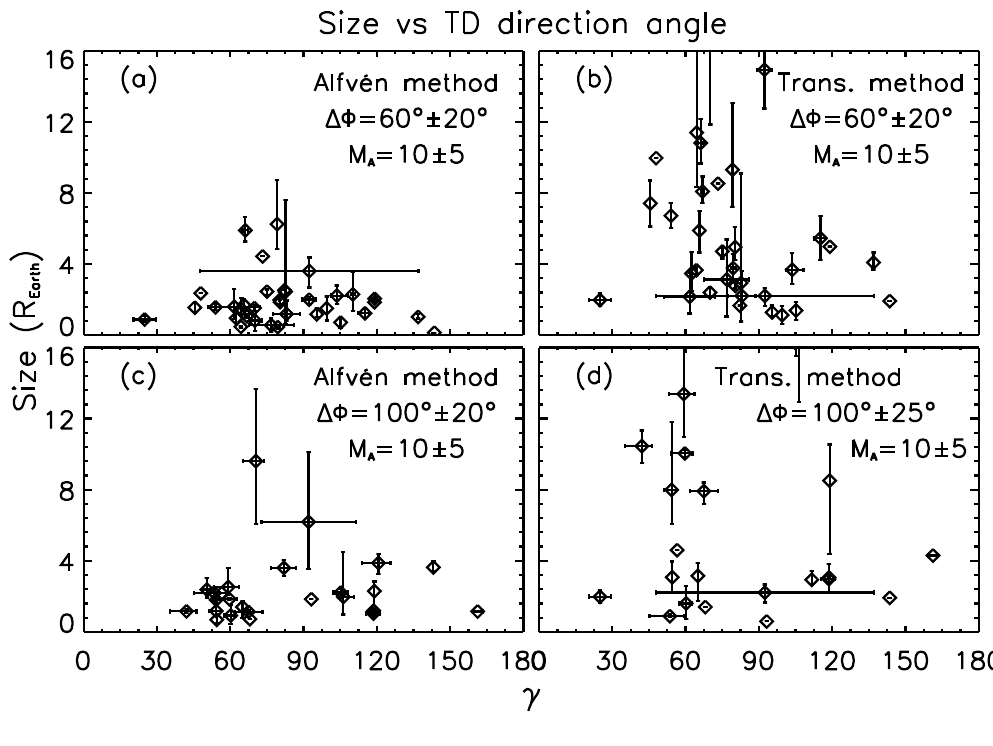
Fig. 6. The size- γ functions based on the size estimation by Alfv´en Mach velocity on the left and the transition speed on the right. The fixed solar wind speed was shown in Alfv´en Mach number. (a) 18 = 60 ◦ ± 20 ◦ and M A = 10 ± 5, (b) 18 = 60 ◦ ± 20 ◦ and M A = 10 ± 5, (c) 18 = 100 ◦ ± 20 ◦ and M A = 10 ± 5, (d) 18 = 100 ◦ ± 25 ◦ and M A = 10 ± 5. All Alfv´en Mach numbers were calculated from the actual Alfv´en velocity. Table 3. Solar wind speed, fast magnetosonic Mach number mean values, and their deviations measured by Cluster CIS and ACE SWEPAM. The last column gives the figure numbers shown on Fig. 9. 2003 2006